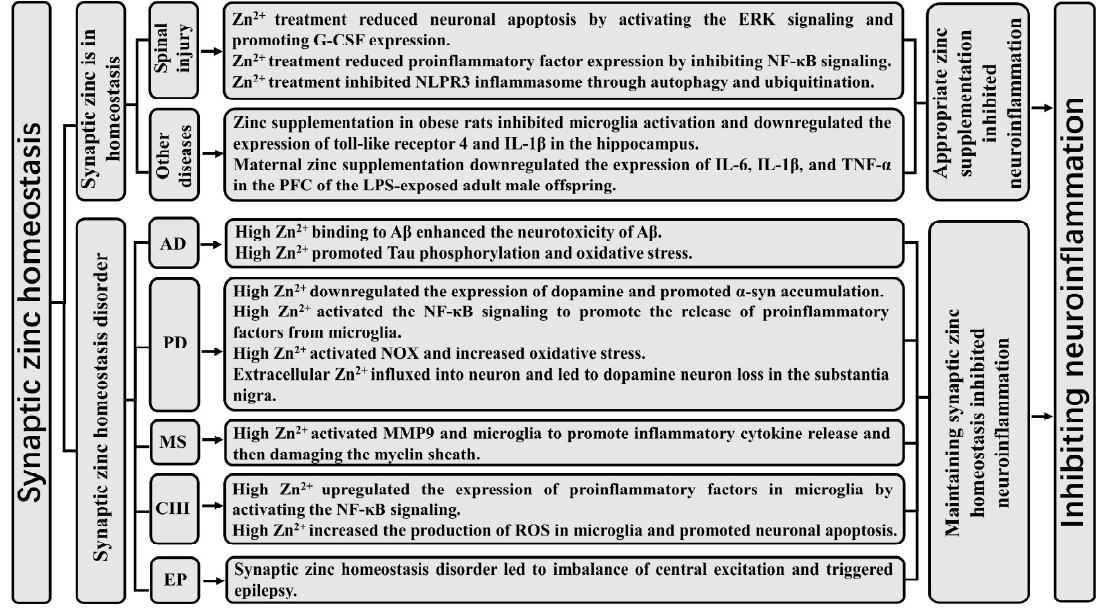
Figure 2. Relationship between synaptic zinc and neuroinflammation. Zinc is an indispensable trace element for maintaining life-preserving activities of organisms. When synaptic zinc is in homeostasis, the appropriate zinc supplementation enhances the body’s utilization of zinc, thereby enhancing the body’s ability to resist neuroinflammation. However, synaptic zinc disorder further damages the synaptic function when suffering from synapse damage-related diseases. Zn 2+ uptake in vitro and the large amount of Zn 2+ released by impaired synapses promote neuroinflammation, so maintaining synaptic zinc homeostasis inhibits neuroinflammation. ERK (extracellular signal-regulated kinase); granulocyte colony stimulating factor (G-CSF); nuclear factor-κB (NF-κB); NOD-like receptor protein 3 (NLRP3); interleukin (IL); tumor necrosis factor-α (TNF-α); prefrontal cortex (PFC); lipopolysac- charide (LPS); Alzheimer’s disease (AD); Parkinson’s disease (PD); multiple sclerosis (MS); cerebral ischemia and hypoxia (CIH); epilepsy (EP); β -amyloid (A β ); α -synuclein ( α -syn); reduced nicoti- namide adenine dinucleotide phosphate oxidase (NOX); matrix metalloproteinase (MMP); reactive oxygen species